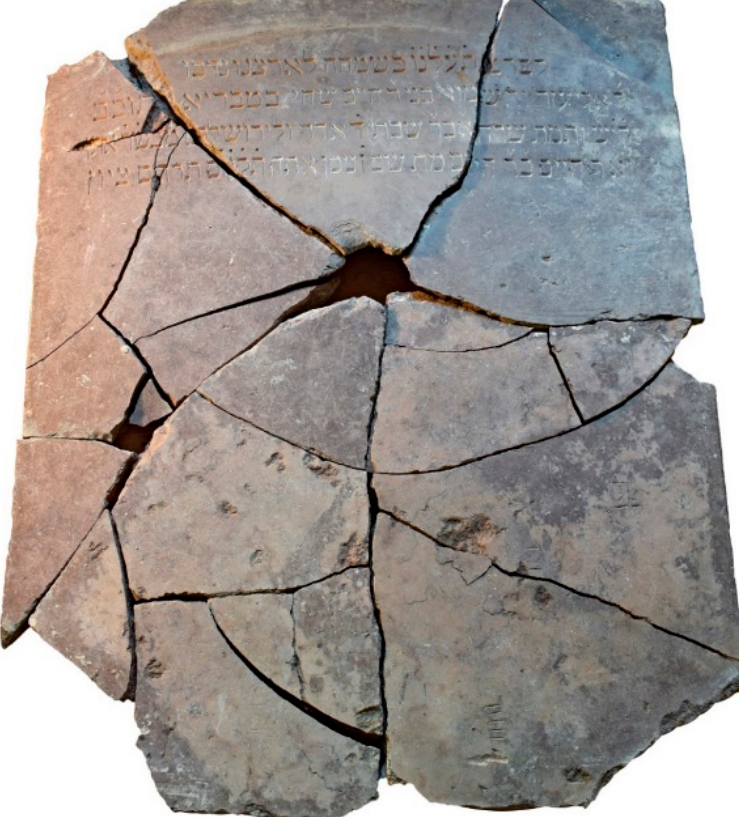
Figure 11. The inscribed slab after the pieces were assembled. Photo: Jon Seligman, Israel Antiquities